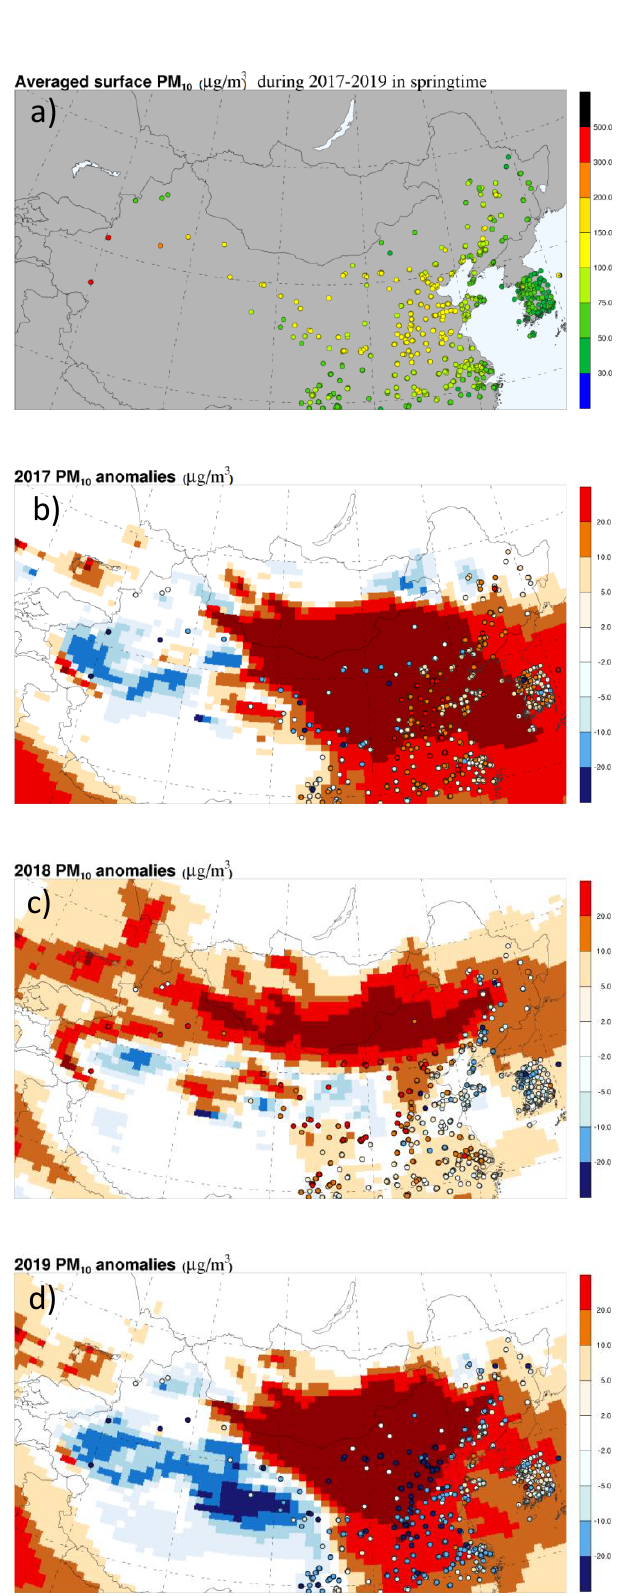
Figure 8. ( a ) Springtime seasonal mean PM 10 mass concentrations observations in South Korea and China averaged during the period from 2017 to 2019, and modeled (colored contour) and measured (dots) springtime PM 10 mass concentration anomalies in each year from 2017 to 2019 ( b – d ).